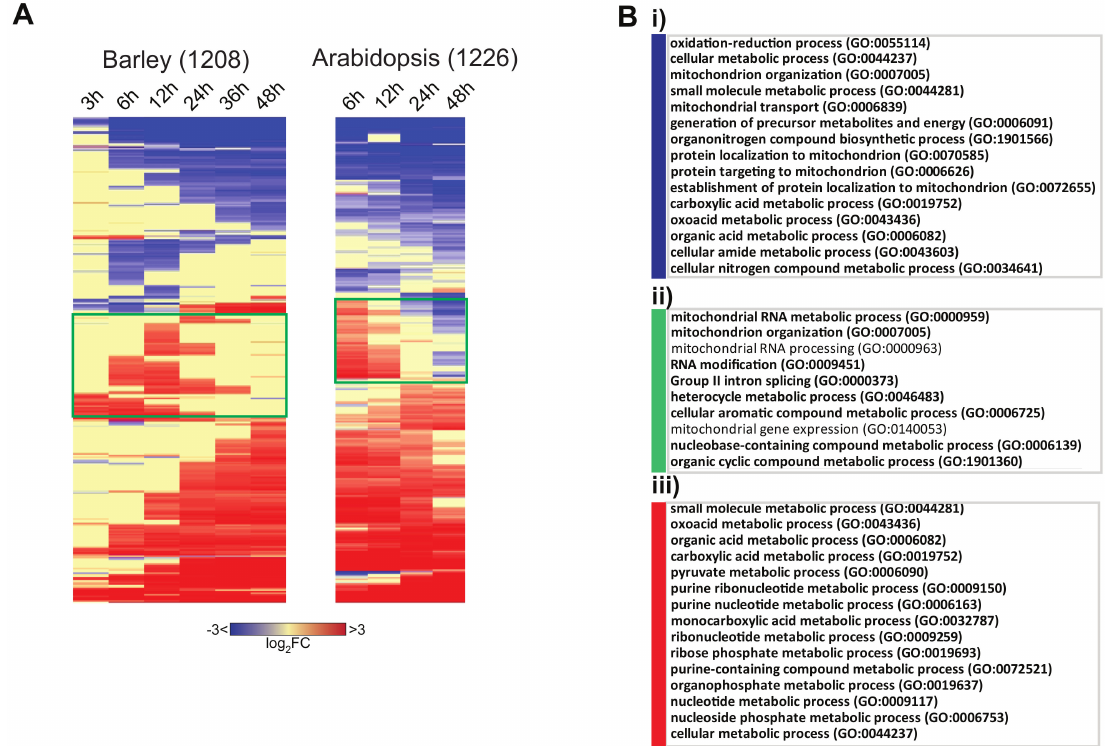
Figure 9. Expression of genes encoding mitochondrial proteins during germination. ( A ) Hierarchical clustering of the fold changes (logFC) compared to 0 h for the 1208 genes encoding mitochondrial proteins in barley and 1226 genes encoding mitochondrial proteins in Arabidopsis